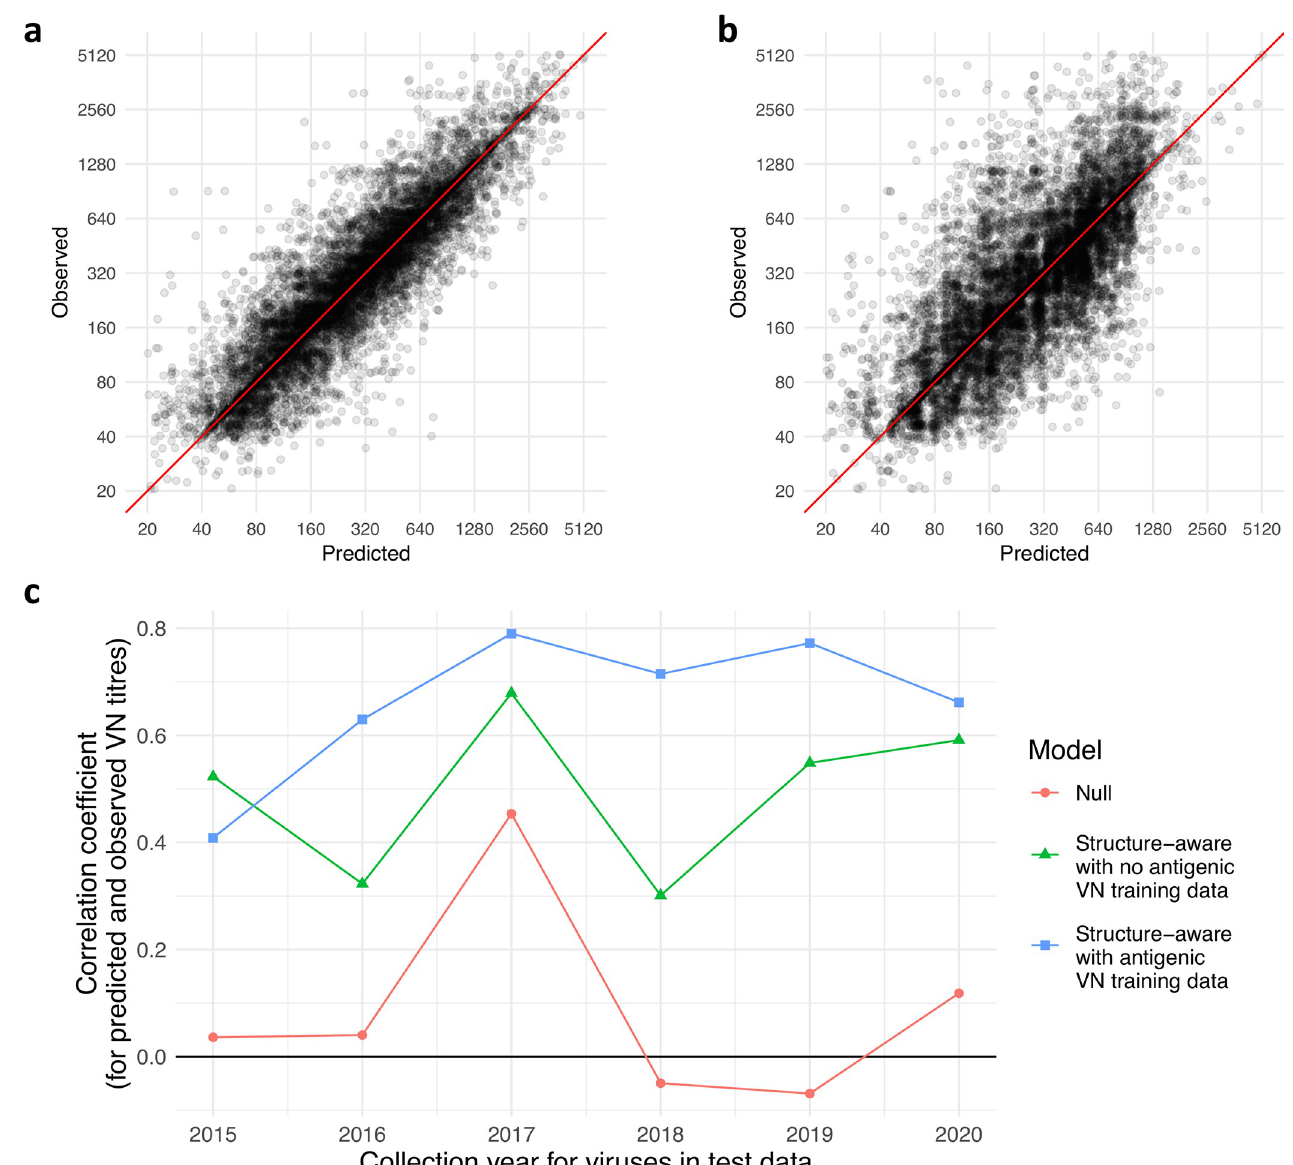
Fig 5. Sequence-based predictions of antigenic phenotype. Measured HI titres are plotted against predictions made under cross-validation procedures where test sets consist of randomly selected ( a ) 10% of test-reference virus pairs and ( b ) 10% of test viruses. Predictions are made using a structurally-aware model ( Eq 6 ) in which structural features associated with the location of each residue in the HA protein influence the combination of genetic terms that contribute to predictions. Observed titres are the fitted titre for each reference strain and test virus, accounting for day-to-day variability in measured titres. ( c ) Pearson’s correlation coefficient between observed titres and predictions made for test sets consisting of VN measurements between viruses collected in a specified year and antisera present in training datasets of viruses collected in previous years. The null model estimates titres based on homologous titre values for antisera in the training dataset only. The structural model with no antigenic information from the training VN data estimates titres using homologous titre values for an antiserum in the training dataset and structure-informed probabilities ( p in Eq 7 ) and position-specific antigenic terms ( ~ m ~ in Eq 6 ) from a structurally-aware l l model applied to HI data collected from 1990–2014 (summarised in Fig 4 ). The structurally-aware model with antigenic information is additionally able to train estimates of antigenic effects of substitutions present in VN training